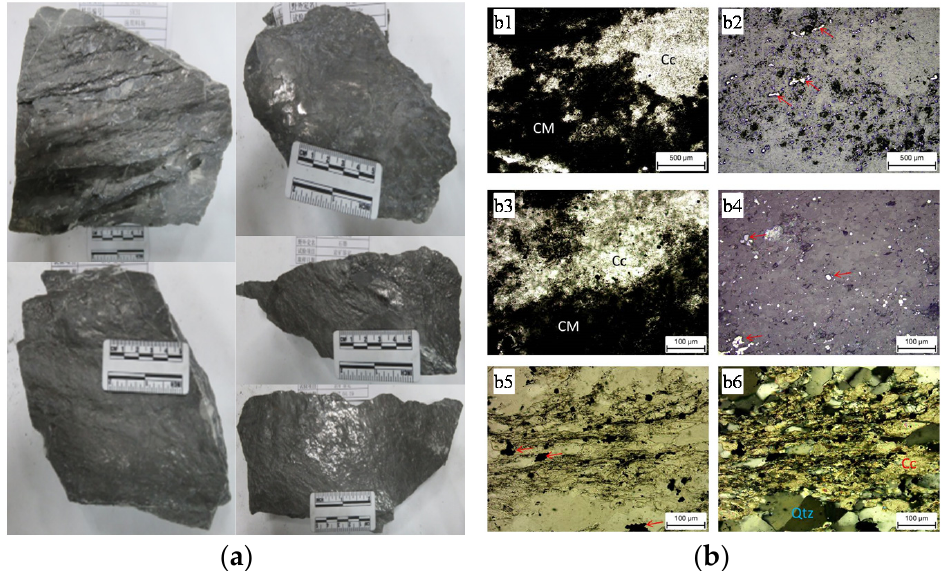
Figure 3. Composition analysis of the CTF: ( a ) Visual observation of CTF hand specimens; ( b ) Rock slice identification.